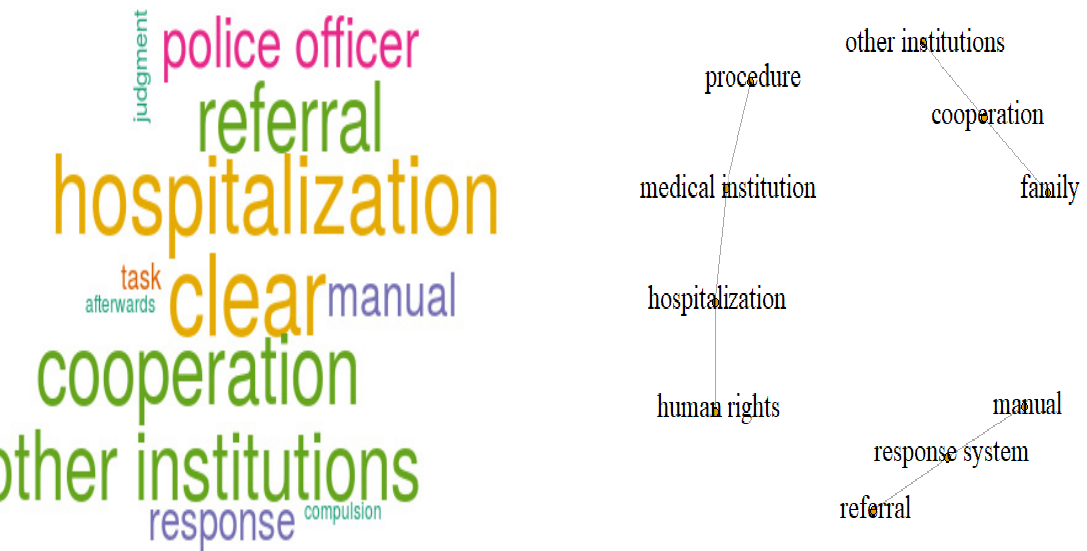
Figure 2. Word cloud analysis of suggestions for additions to the on-site response manual.